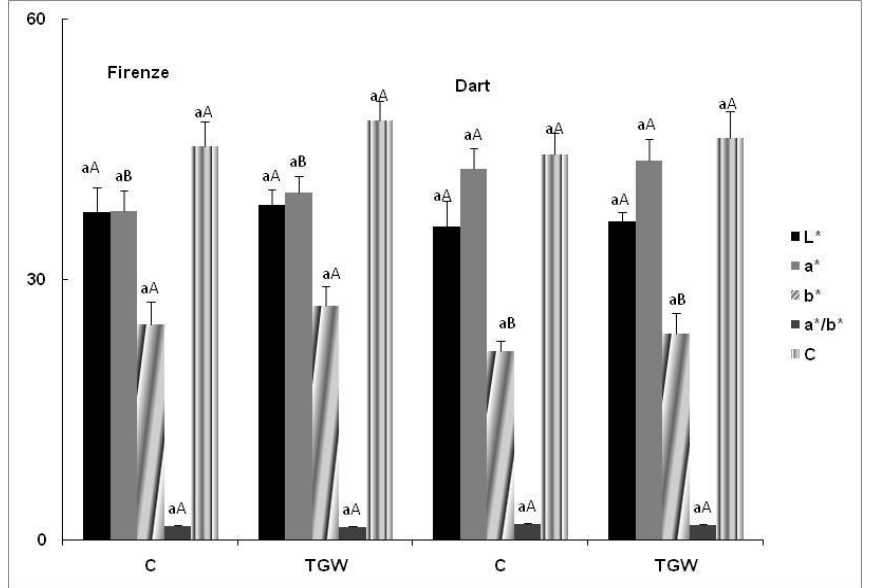
Figure 2. Effect of treated grey water on tomato flesh color. L* (lightness), a* ( − a* = greenness, +a* = redness), b* ( − b* = blueness, +b* = yellowness), a*/b* and C* (chroma). Values are means ± SE n = 4, different lowercase letters indicate significant difference among treatments and different uppercase letters indicate significant difference between cultivars according to LSD test at p ≤ 0.05.